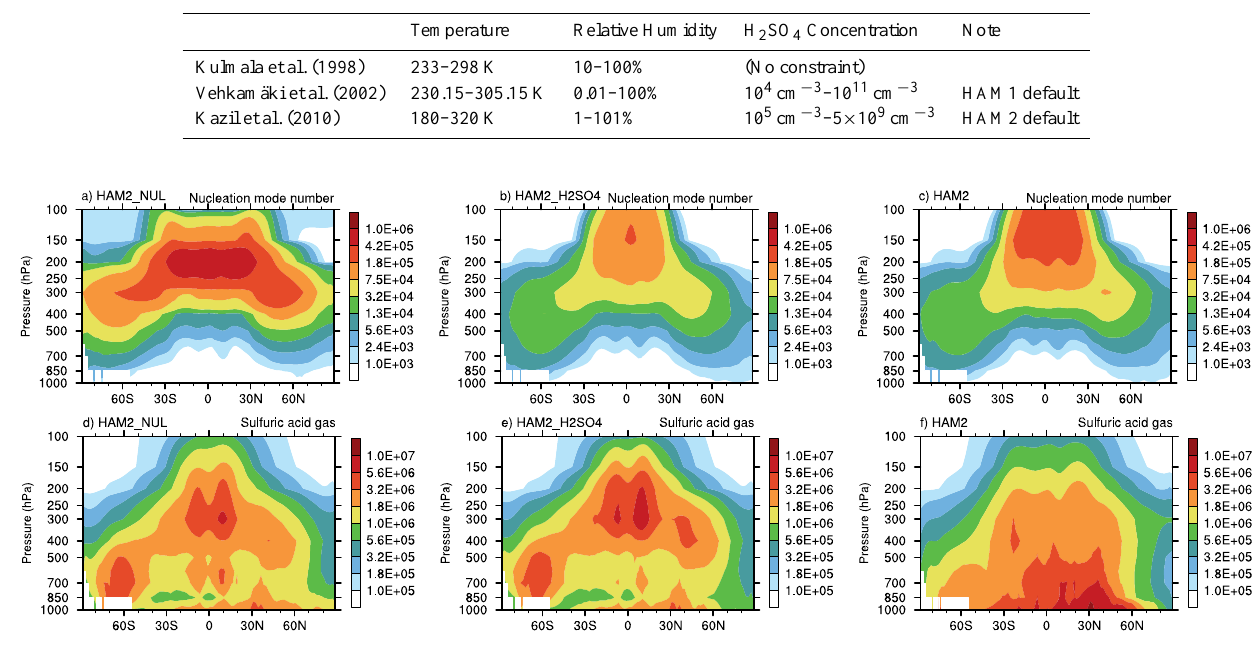
Fig. 2. Annual and zonal mean vertical cross-sections of the number concentration of nucleation mode particles (upper row, unit: par- ticlescm − 3 STP (1013.25hPa, 273.15 K)) and mass concentration of H 2 SO 4 gas (lower row, unit: moleculescm − 3 ). The three columns correspond to different simulations, as indicated by the title of each panel: “HAM2” refers to the standard ECHAM-HAM2 configuration; “HAM2 H2SO4” uses the Kazil et al. (2010) aerosol nucleation scheme but the old handling of the H 2 SO 4 equation (cf. Sect. 4.1.1); “HAM2 NUL” is similar to “HAM2 H2SO4” but uses the Vehkam¨aki et al. (2002) nucleation parameterization. All other aspects of model configuration are identical in the three